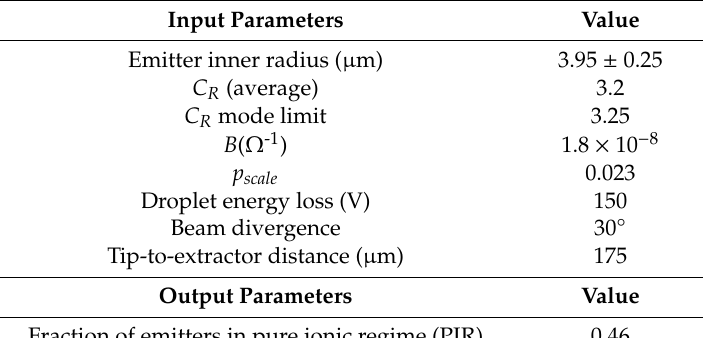
Table 8. Benchmarking parameters for results in Table 7 and Figure 12. Figure 13. VI curves for ions and droplets computed for the circuit shown in Figure 12.